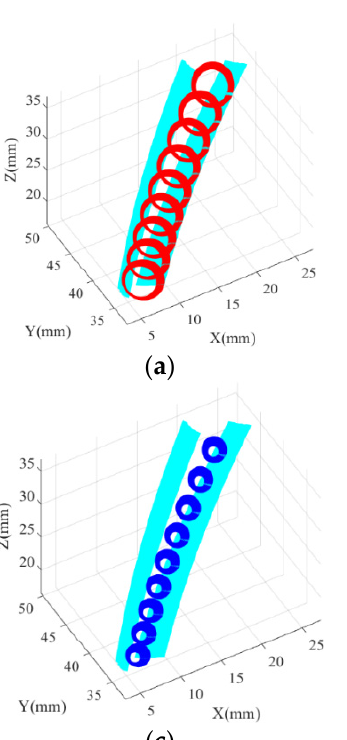
Figure 11. Simulation machining experiment with SolidCam: ( a ) Machining the convex tooth surface; ( b ) Machining the transition tooth surface; ( c ) Machining the concave tooth surface; ( d ) Machining the root tooth surface.